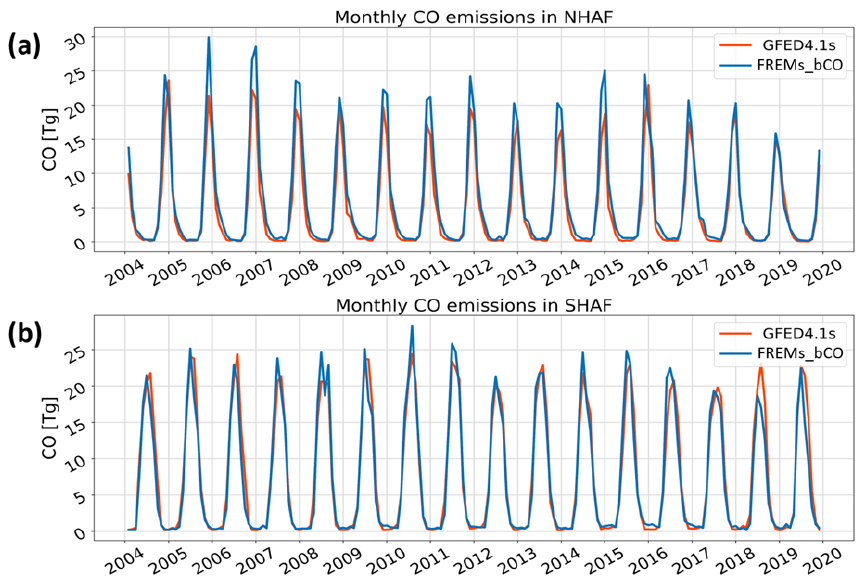
Figure 3. Monthly landscape fire CO emissions over a 16-year period for (a) Northern and (b) Southern Hemisphere Africa, as derived in FREMs_bCO and GFED4.1s, both with their respective small fire correction applied (“s” indicates its application). Table 3. Mean annual CO fire emission totals for the period 2004 to 2019 as derived for Northern and Southern Hemisphere Africa using the FREM methodology developed herein and reported alongside those of GFEDv4.1. Values are reported as those both with and without the relevant small fire correction applied (“s” indicates its application), as well as the percentage difference made by this upward adjustment. NHAF total CO Without small